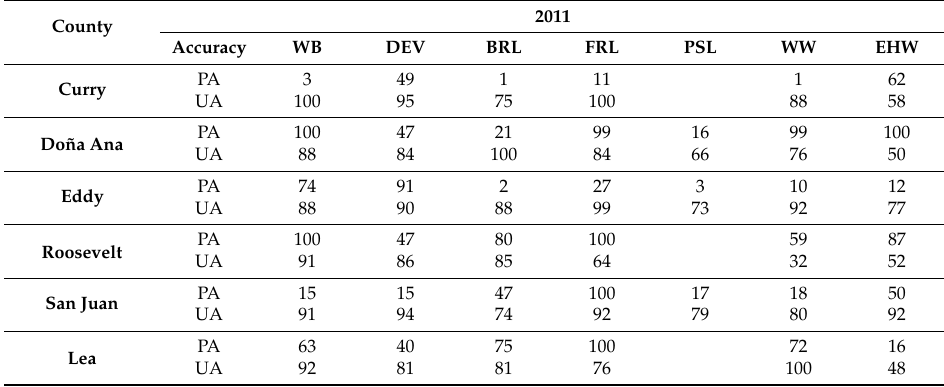
Table A5. User’s and producer’s accuracy for the rest of the LULC classes for the NLCD map of 2011. County 2011